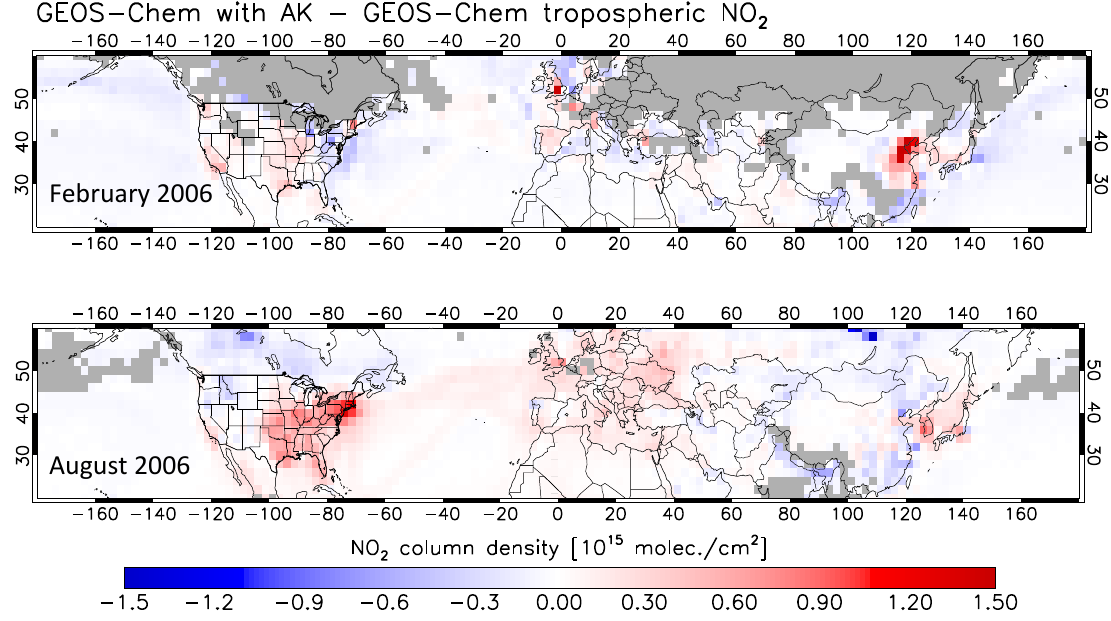
Figure 8. Difference between monthly mean GEOS-Chem with AK (Eq. 6) and GEOS-Chem tropospheric NO 2 columns without AK for February 2006 (upper panel) and August 2006 (lower panel). Only grid cells with more than 3 days of better than 40% coverage of clear-sky pixels have been selected. Table 1. Summary of tropospheric NO 2 GEOS-Chem model evaluations following recipes (A), (B), and (C) with OMI NO 2 retrievals for February and August 2006. n refers to the number of grid cells used in the comparison. R